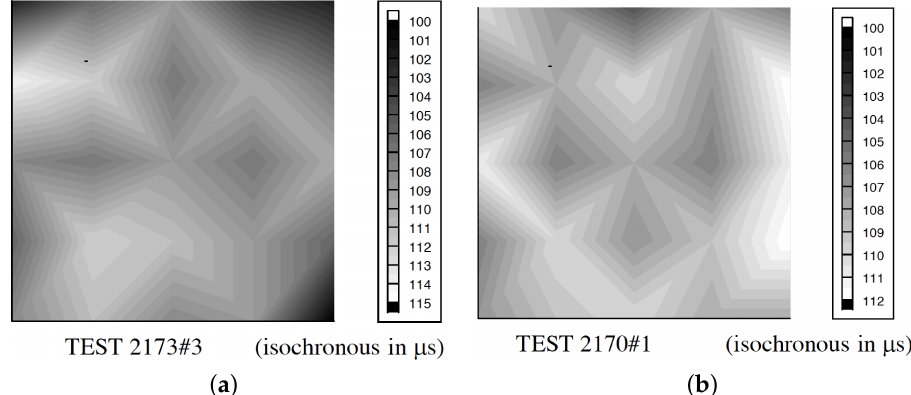
Figure 2. Crack propagation measured by means of the Hopkinson bar bundle device [41] on concrete